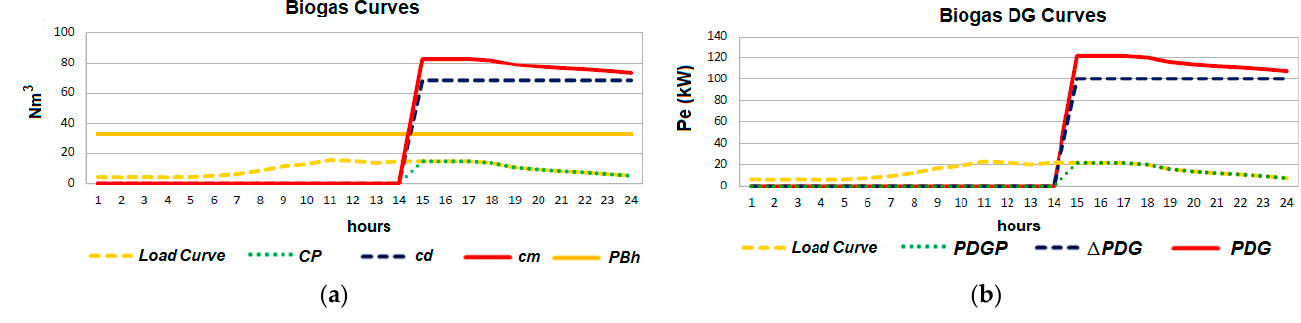
Figure 10. Case 1: ( a ) Biogas curves; ( b ) MOR from biogas DG.